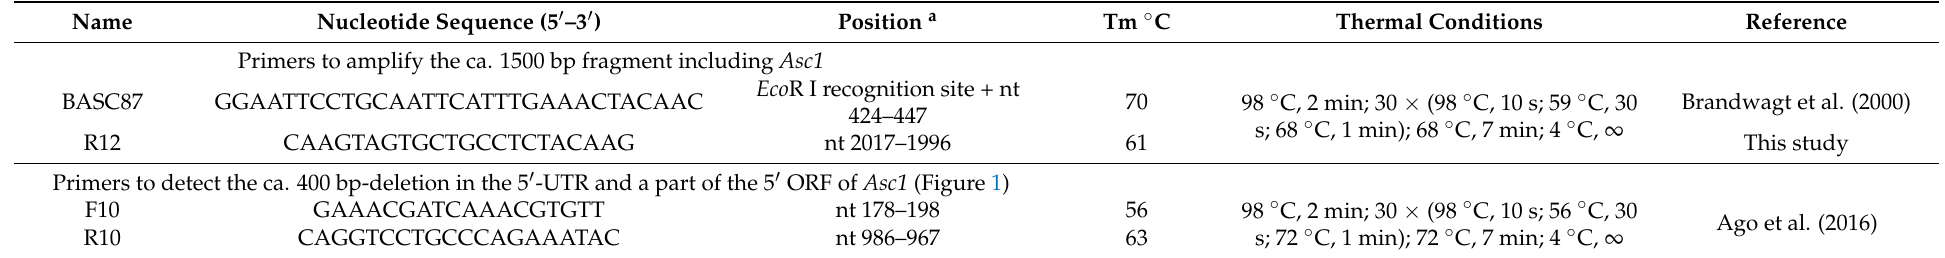
Table 2. Asc1 primers used in this